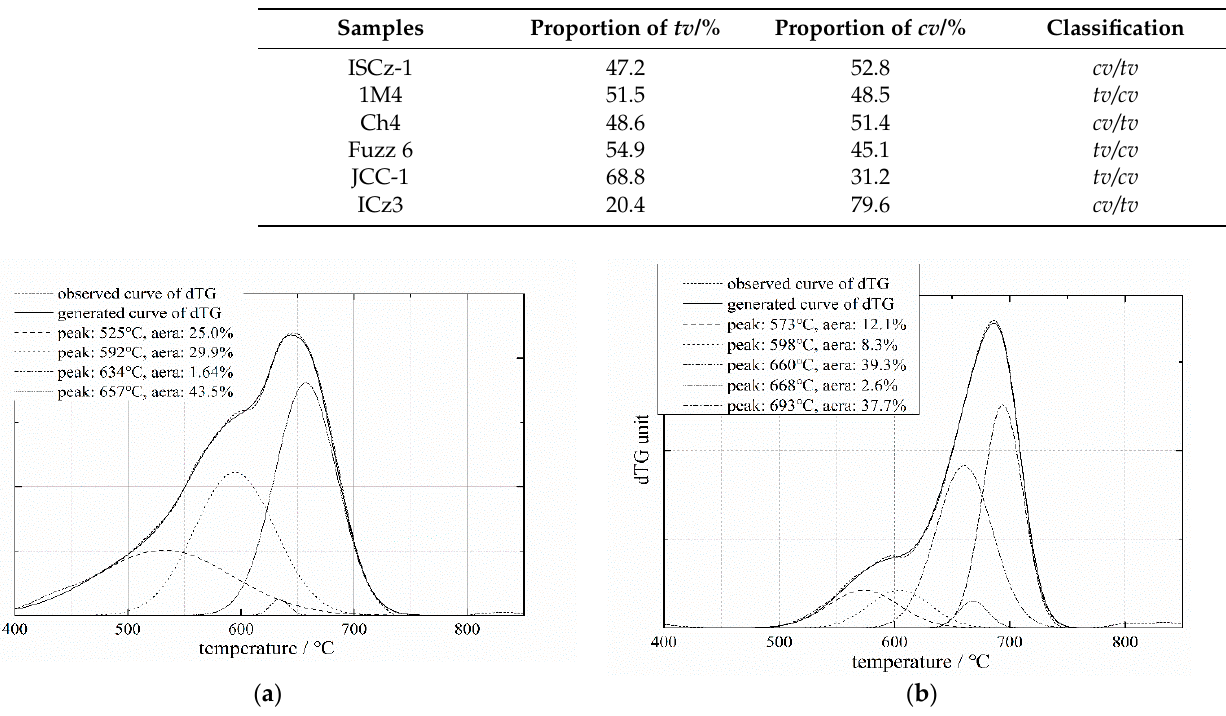
Figure 3. Examples of derivative thermogravimetry (dTG) curves of samples. ( a ) Sample Fuzz 6 with 45.1% of cv layers; ( b ) Sample ICz3 with 79.6% of cv layers.